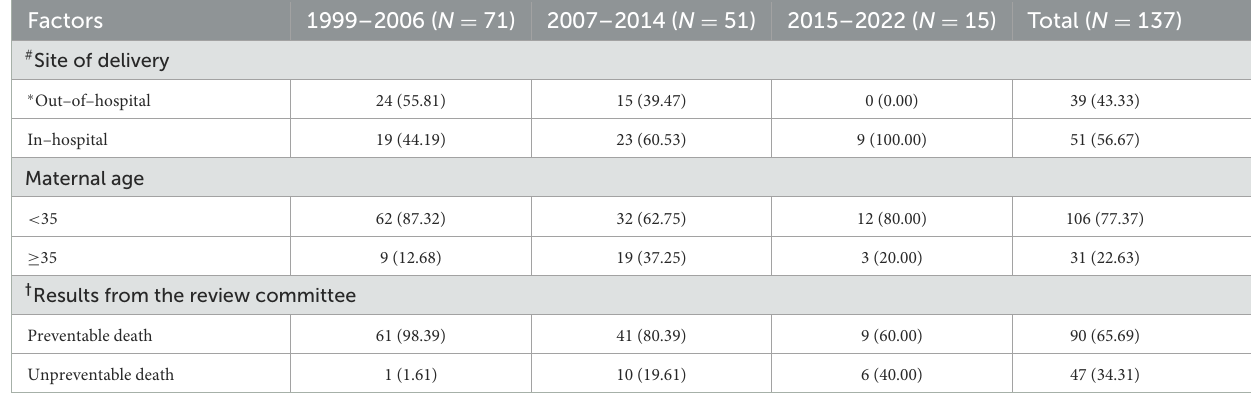
TABLE 4 The constituent ratio differences of maternal deaths in Baoan district during different periods [n,